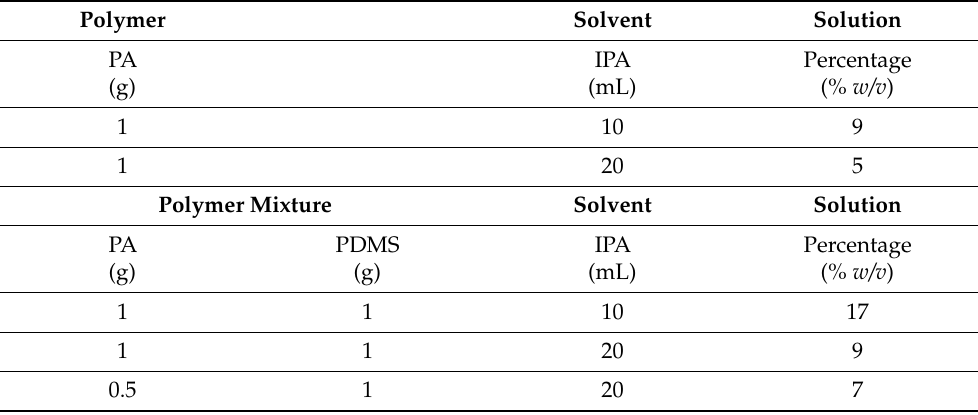
Table 1. Parameters/conditions for preparation/electrospinning of